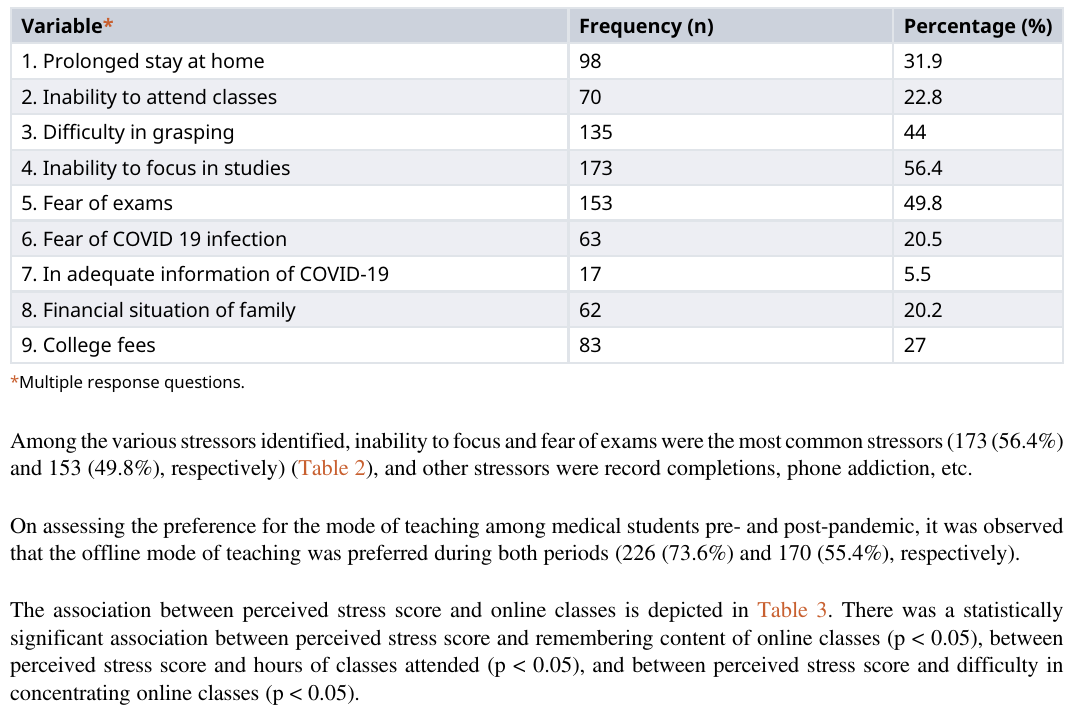
Table 2. Different stressors of students (n=307).